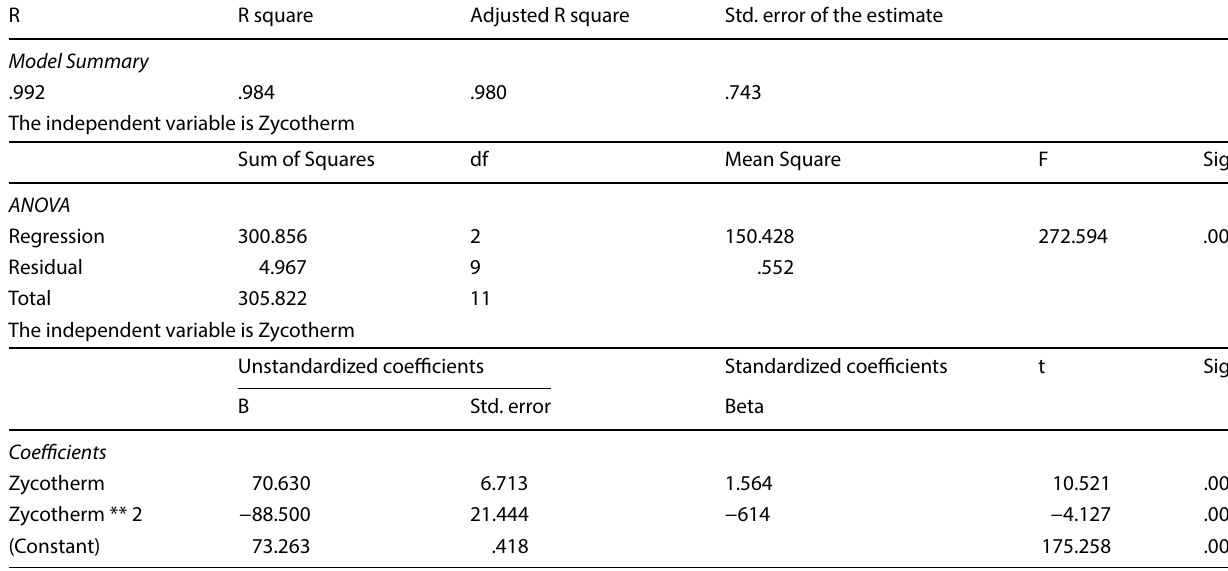
Table 7 Statistical analysis of TSR regression model—Potassium Acetate